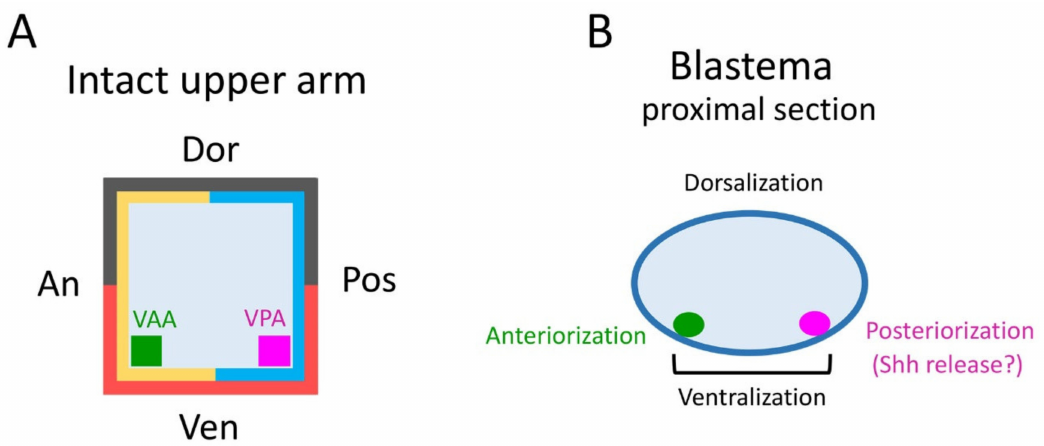
Figure 8. A hypothesis of subcutaneous area involved in the axial patterning of the blastema. ( A ) Schematic showing a cross section of an intact upper arm. Essential tissues that give rise to blastemal mesenchymal cells which work for axial patterning of the blastema may be localized under the ventral anterior and ventral posterior skin (green and magenta). VAA: Ventral Anterior Area. VPA: Ventral Posterior Area. ( B ) Schematic showing a cross section of a proximal part of the blastema. Green and magenta show blastemal cells originating from VAA and VPA, respectively. Magenta cells may play a role in posteriorization of the blastema by forming posterior digits. It may correspond to the Zone of Polarizing Activity (ZPA) in the limb bud, which secretes Shh. Green cells may work, together with magenta cells, to ventralize as well as anteriorize the